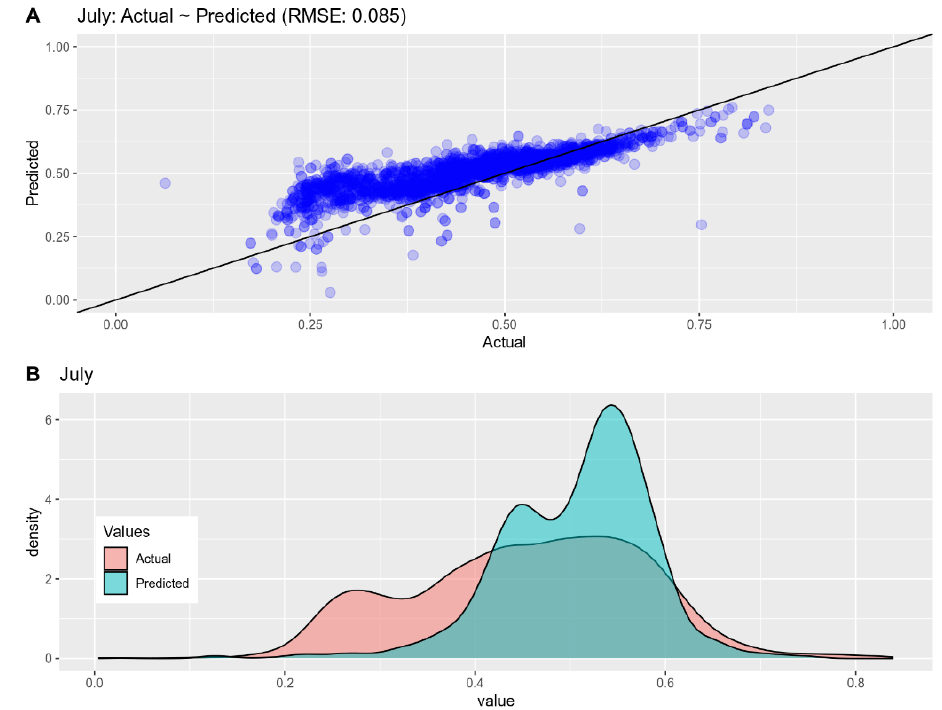
Figure A7. Comparison between actua~predicted for July 2020.